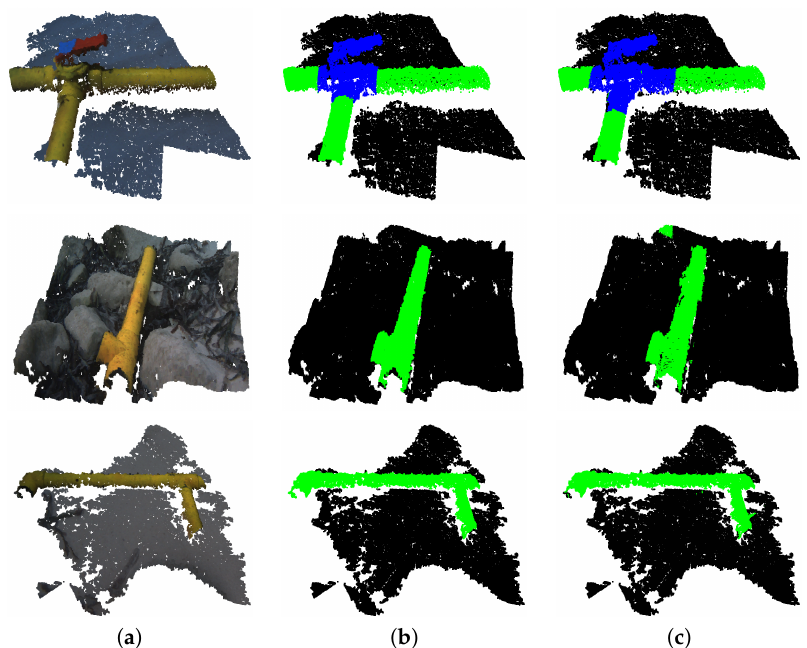
Figure 10. Qualitative results for the Sea test set. ( a ) original point cloud; ( b ) ground truth annotations; ( c ) network